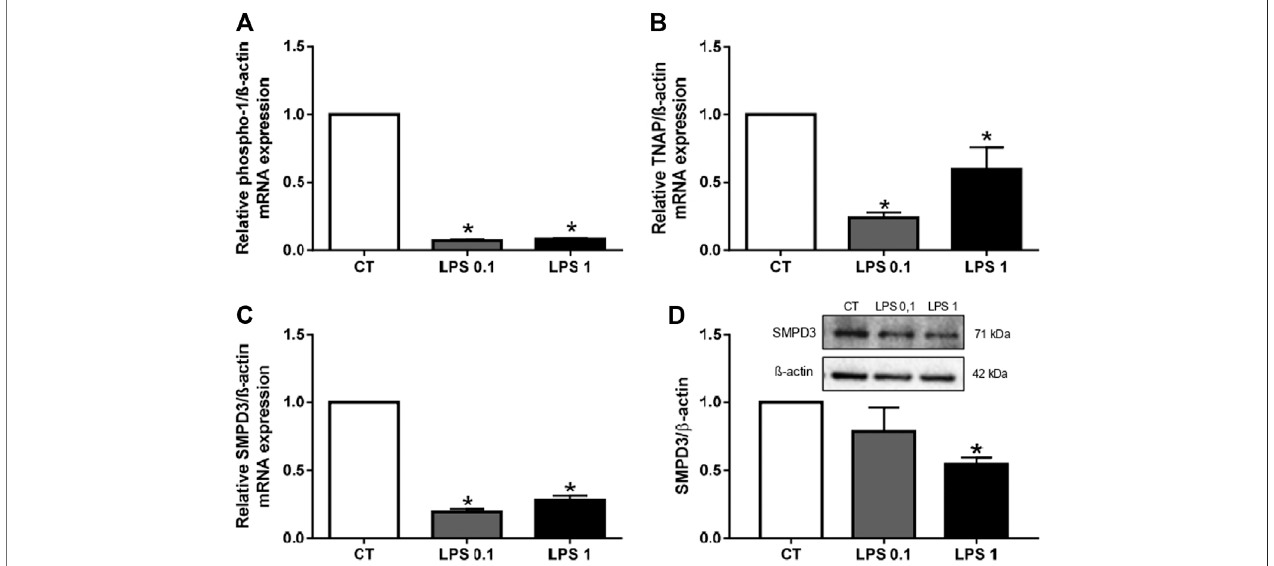
FIGURE3| Lipopolysaccharide-EK(LPS-EK)decreasesEVbiogenesisinmacrophages.RAWcellswereincubatedwithLPS-EKfor6 h.GeneexpressionofEVof the biogenesis markers (A) phospho-1, (B) TNAP, and (C) SMPD3 was then quanti fi ed by RT-qPCR and normalized to that of the housekeeping gene ß-actin. (D) SMPD3 protein expression was studied by western blotting and normalized to that of the housekeeping gene ß-actin. Data are expressed as the mean ± SEM of four independent experiments performed in triplicate ( n = 4). * p < 0.05 vs . CT, Mann-Whitney test. LPS 0.1: 0.1 µg/ml LPS-EK, LPS 1: 1 µg/ml LPS-EK.